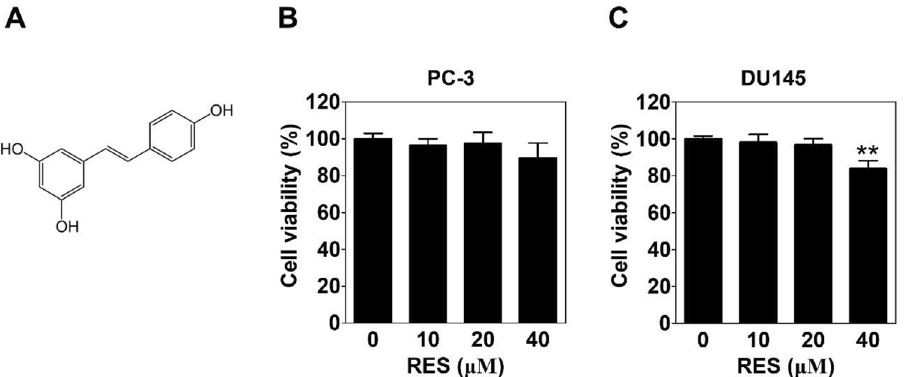
Figure 1. Effect of resveratrol on the cell viability against prostate cancer cells. ( A ) Chemical structure of resveratrol. PC-3 ( B) or DU145 ( C ) cells were treated with various concentrations of RES for 24 h followed by the MTT assay. Data present as the means ± SD of triplicate